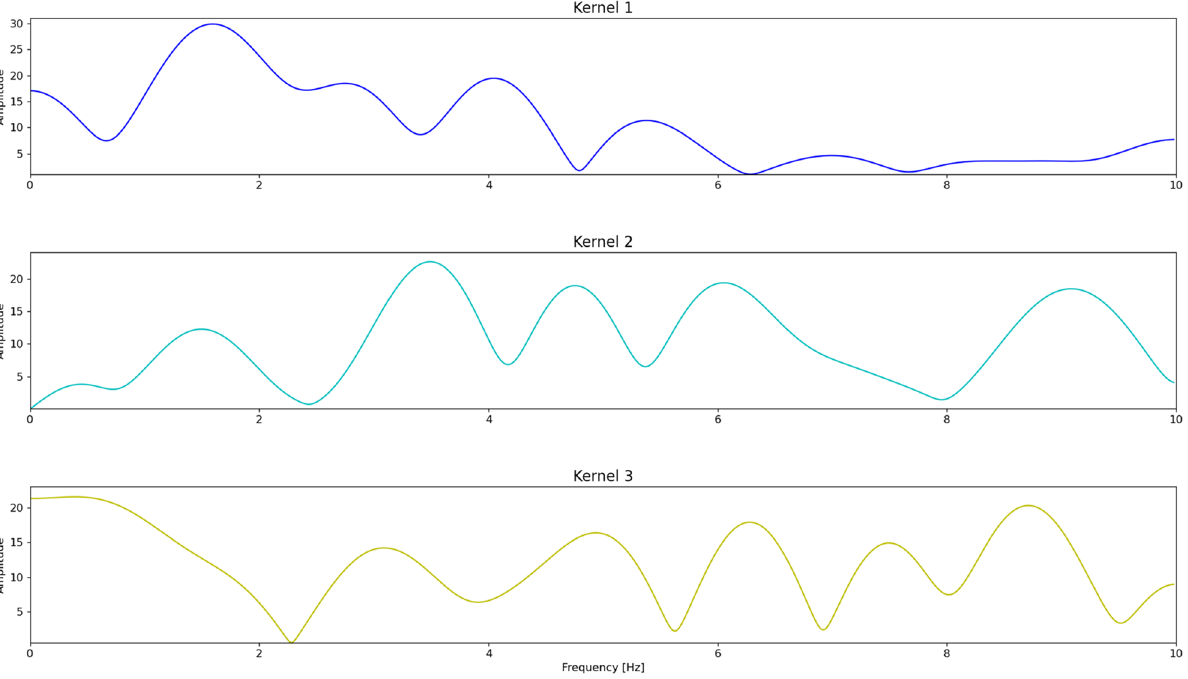
Figure 6. Frequency responses of the 3 kernels in the first convolutional layer of Optimized CNN network. Frequencies above 5 Hz are not significant because the signals were previously filtered below 5.5